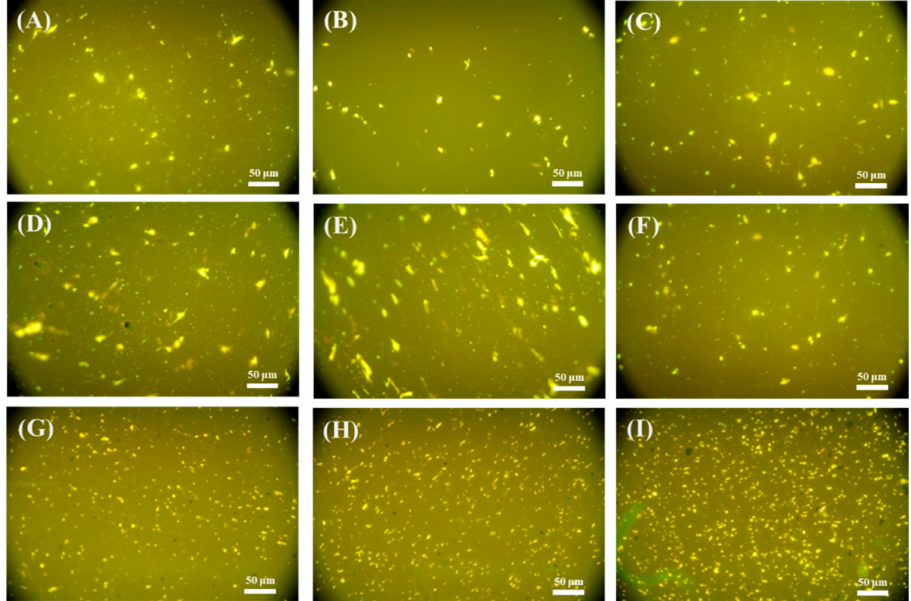
Figure 13. Fluorescence microscopy of all samples ( × 400): ( A ) K0; ( B ) K5; ( C ) K10; ( D ) K15; ( E ) K20; ( F ) KP0.5; ( G ) KP1.0; ( H ) KP1.5; ( I )